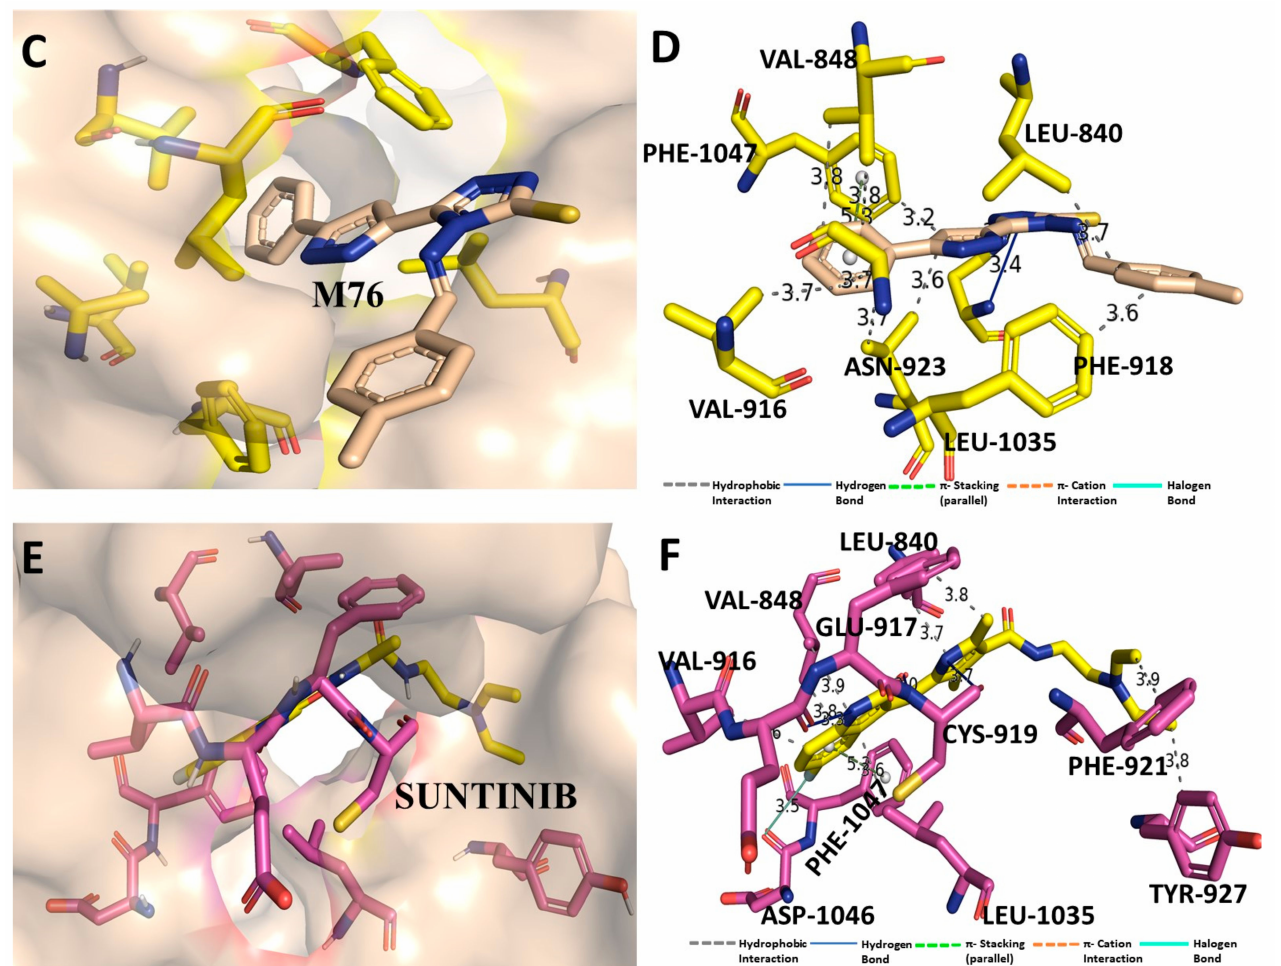
Figure 8. ( A ) Molecular docking-generated binding orientations of standard compound (sunitinib) and the proposed pyrazole-based inhibitor compound M76 in complex with VEGFR (4AGD) protein; ( B ) close-up binding interaction view exhibiting similar binding pattern of all the compounds at the active site cavity of VEGFR (4AGD) protein; ( C ) binding mode of pyrazole compound M76 in the active site cavity of VEGFR (4AGD) displayed in surface view; ( D ) molecular binding interaction and orientation of compound M76 with VEGFR (4AGD) protein; ( E ) binding mode of standard compound (sunitinib) in the active site cavity of VEGFR (4AGD) displayed in surface view; ( F ) molecular binding interaction and orientation of sunitinib with VEGFR (4AGD)